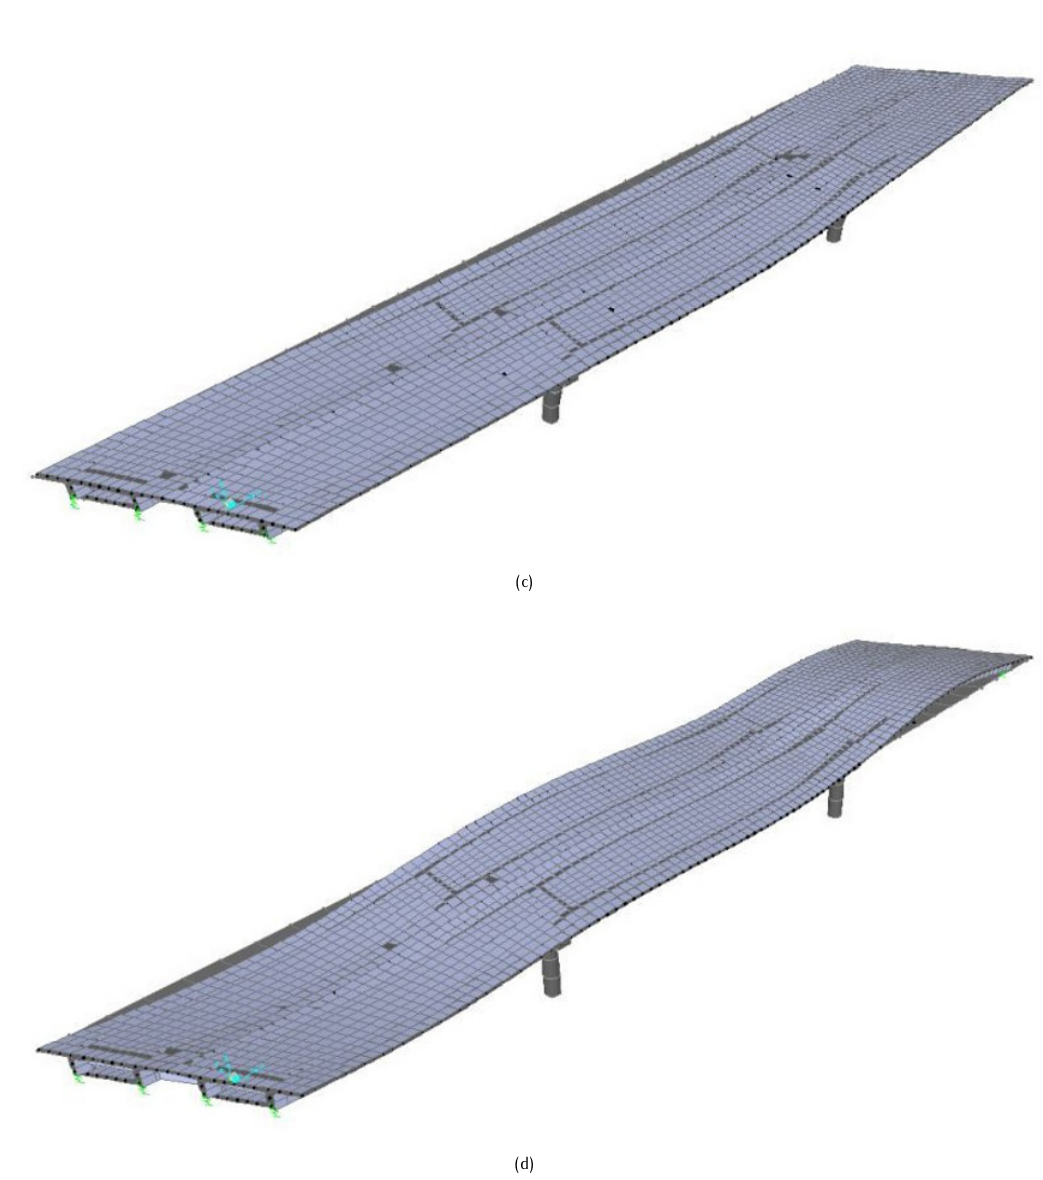
Figure 17. (continued) The mode shapes of modal after strengthening: (c) mode No.3, (d) mode